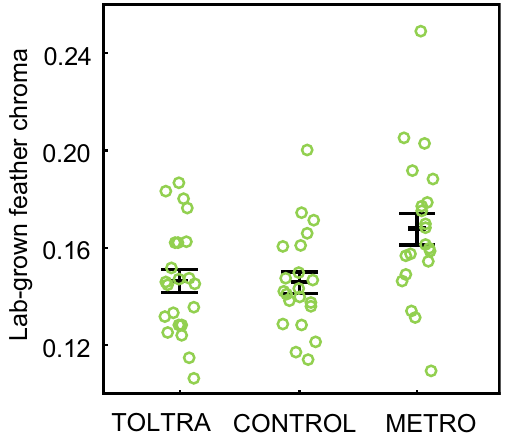
Figure 3. The effect of treatment on feather chroma. The treatment affected chroma of the yellow parts of the lab-grown feathers—birds that received metronidazole (METRO) medication had higher chroma than in the control group and in the toltrazuril (TOLTRA) group. Whiskers denote mean ± s.e.m.